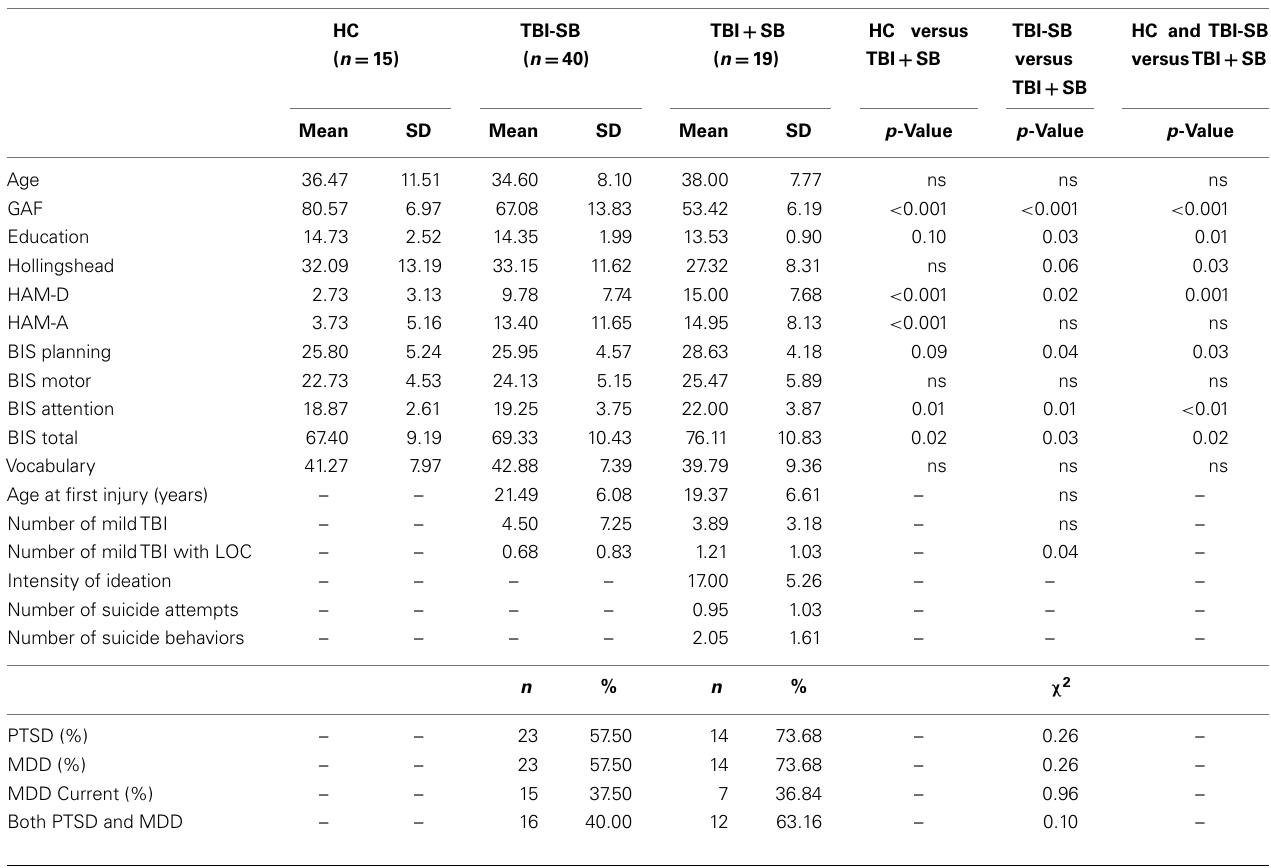
Table 1 | Demographic and clinical